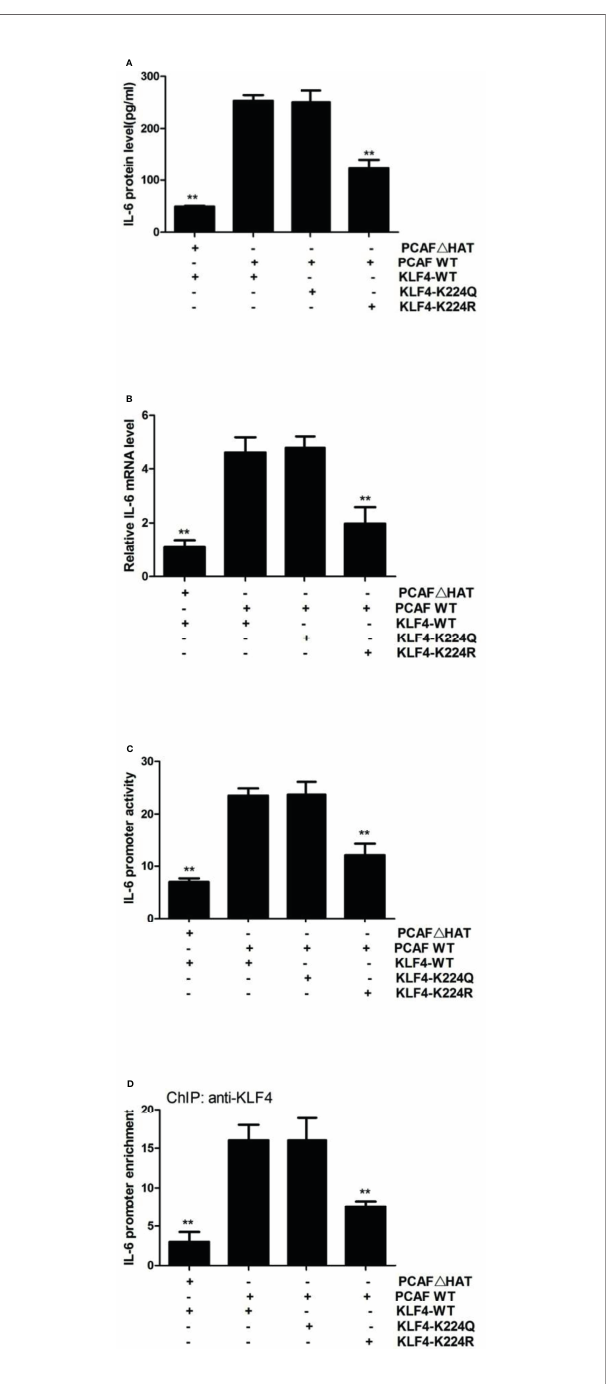
FIGURE 5 | Effect of KLF4 acetylation by PCAF on IL-6 gene transcription in GMCs exposed to sublytic C5b-9. GMCs were transfected with wild-type PCAF (PCAF WT), PCAF HAT-de fi cient mutant (PCAF D HAT), wild-type KLF4 (KLF4 WT), acetylation-de fi cient mutant (KLF4-K224R), or hyper-acetylated mutant (KLF4-K224Q) for 48 h. (A) ELISA of IL-6 in supernatants of GMCs. (B) qPCR analysis of IL-6. (C) Luciferase activity assay of IL-6 reporter ( − 1,791 to +30 nt). (D) ChIP – qPCR analysis of KLF4 enrichment on IL-6 promoter ( − 372 to − 166 nt). **p < 0.01 vs. PCAF WT + KLF4 WT. Data are shown as mean ± SD from three independent experiments. GMCs, glomerular mesangial cells; ChIP, chromatin